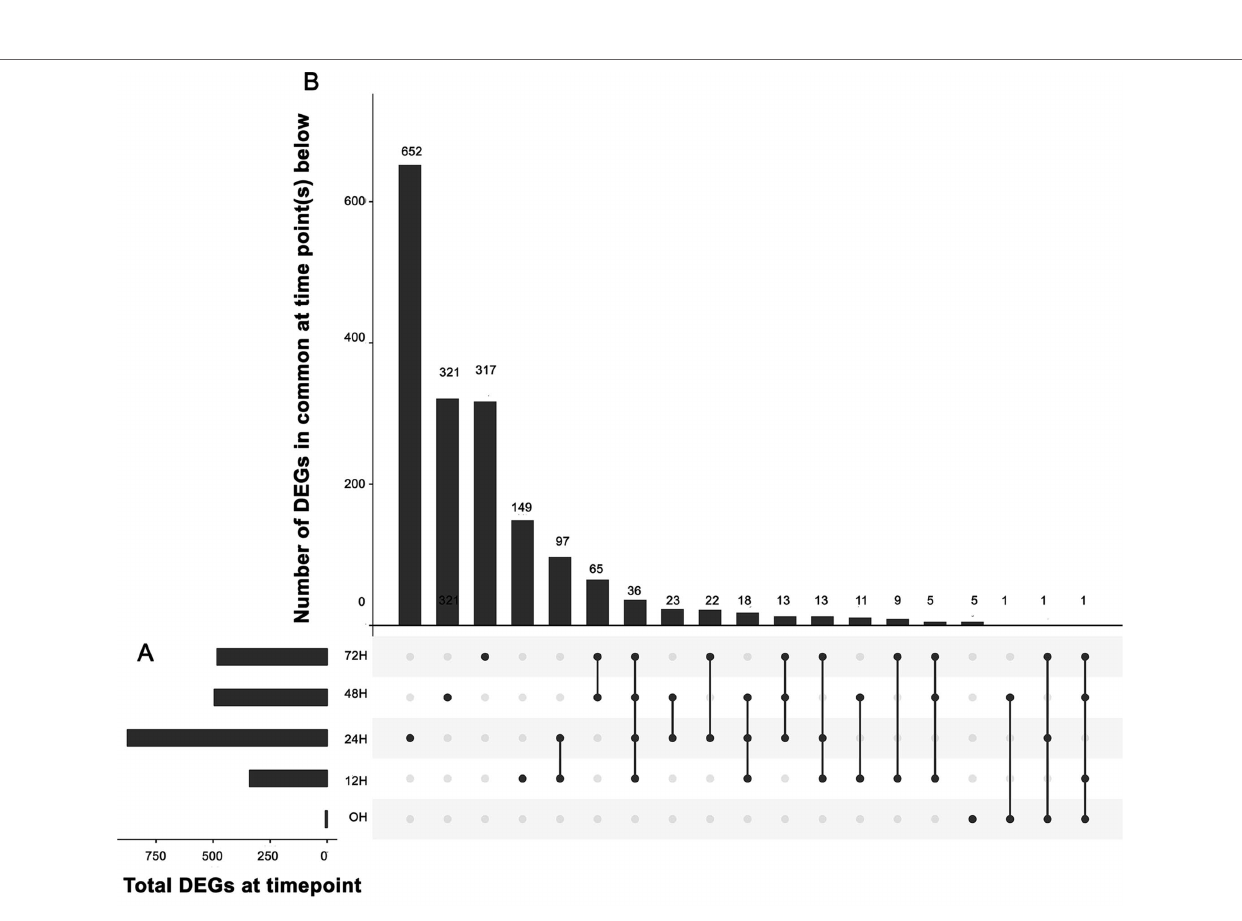
FIGURE 2 | UpSet plot of differentially expressed genes. (A) Graph of total number of differentially expressed genes (DEGs) (X axis) at each time point (Y axis). (B) Intersection of sets of genes at multiple time points. Each column corresponds to a time point (first four columns) or set of time points (dots connected by lines below the X axis) containing the same DEGs. The number of genes in each set appears above the column, while the time points shared are indicated in the graphic below the column, with the time points on the